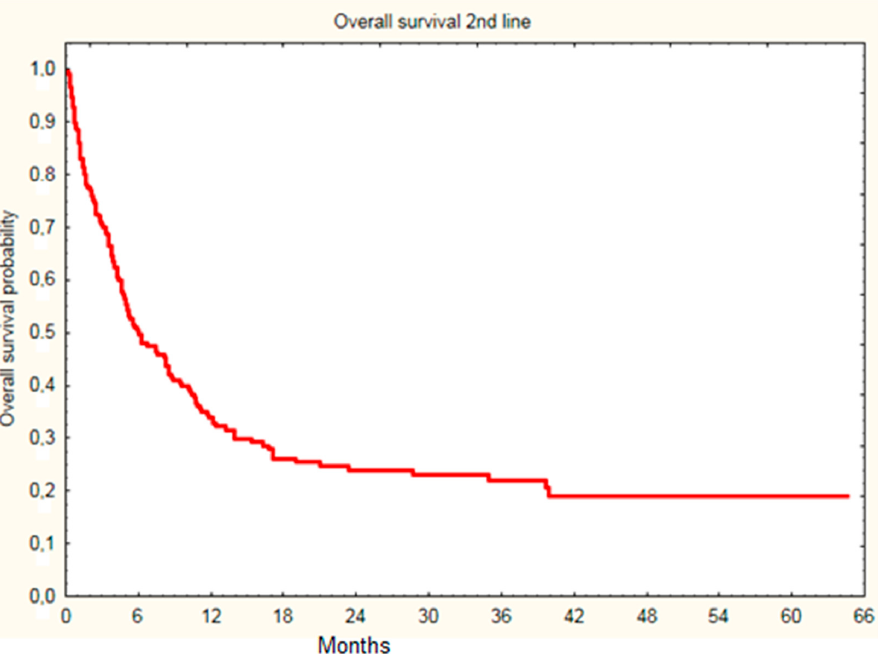
Figure 1. Overall survival of melanoma patients since initiation of second line immunotherapy (nivolumab or pembrolizumab) treatment (18.7 month median).